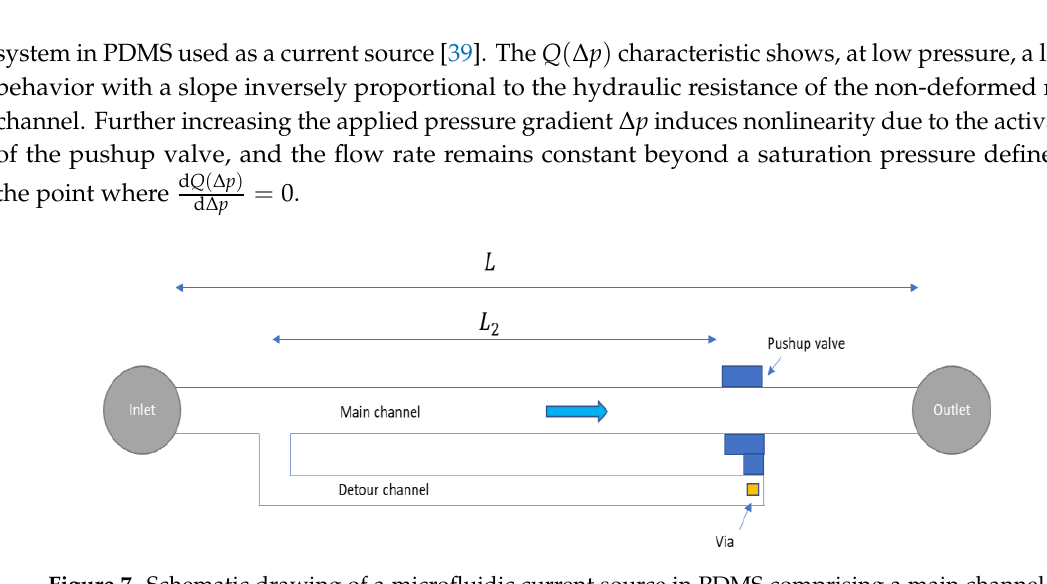
Figure 7. Schematic drawing of a microfluidic current source in PDMS comprising a main channel, a detour channel, and a pushup valve. The flow direction is indicated by the arrow (forward bias). The main and detour channel lengths are noted L and L 2 , respectively. The increase of the inlet pressure generates a larger pressure drop along the main channel and thus the pushup valve will progressively obstruct the main channel and lead, beyond a saturation pressure, to a constant flow rate (adapted from Reference [39]).